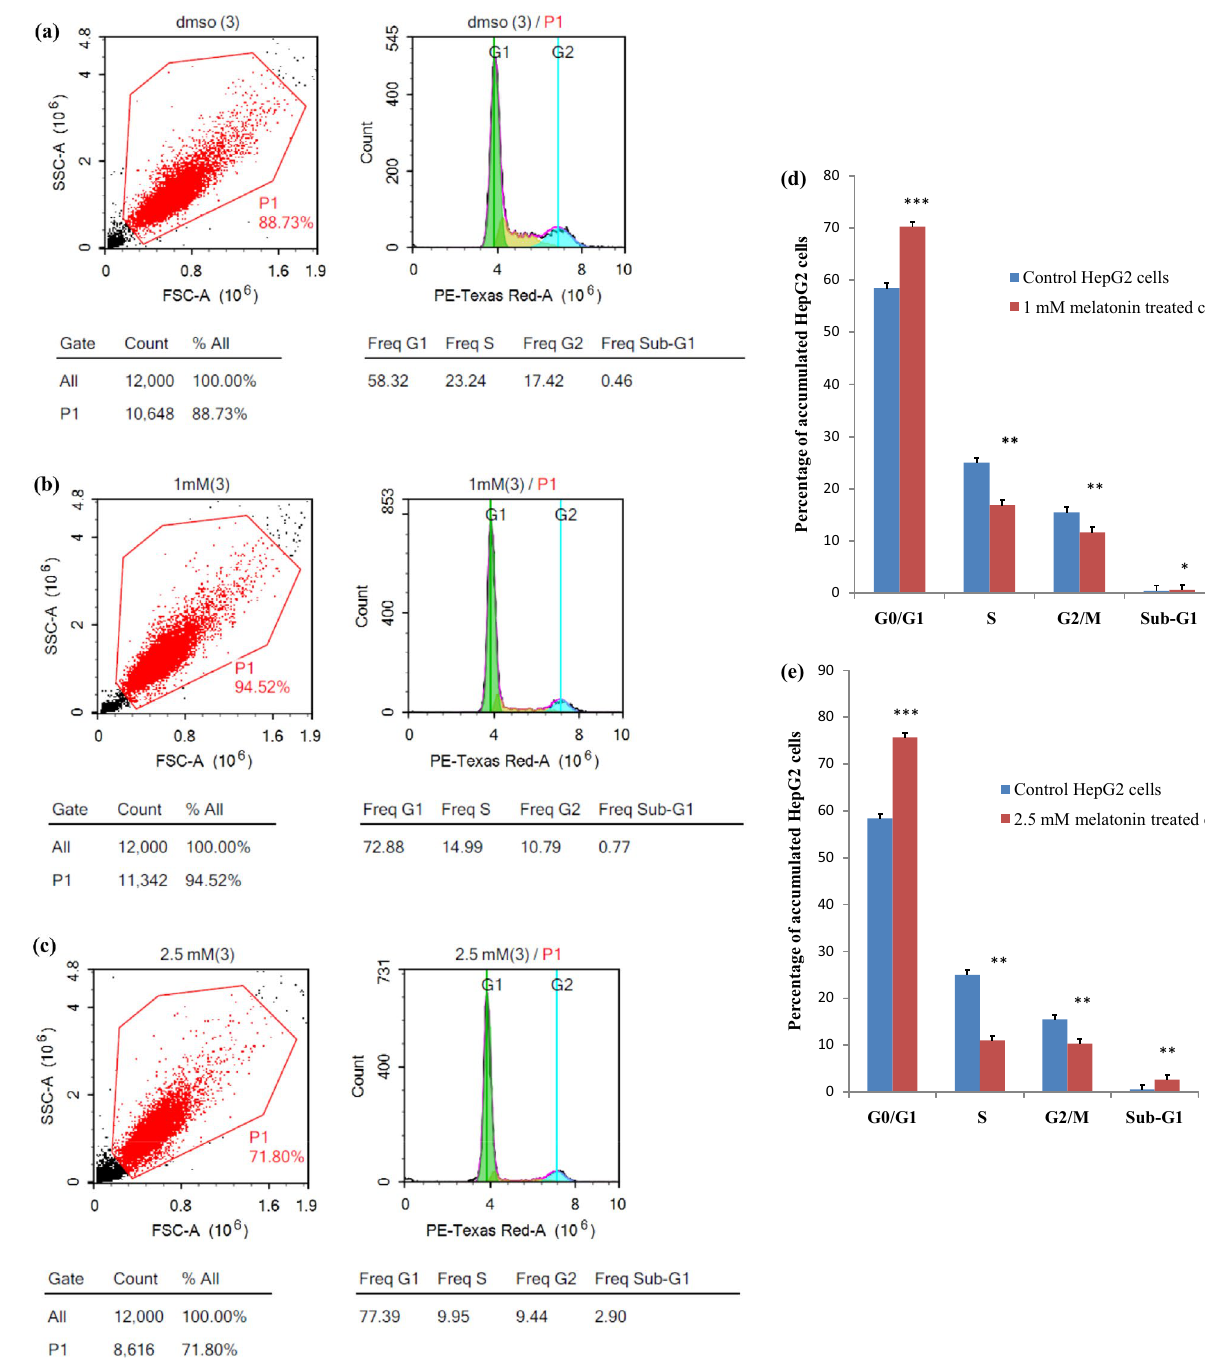
Figure 2. The cell cycles arrest induction by melatonin treatment. The effect of melatonin doses (1 mM, and 2.5 mM) for 24 h on HepG2 cell cycle distribution using flowcytometry is shown in representative charts ( a ) Cell cycle distribution in control vehicle untreated HepG2 cells, ( b ) cell cycle distribution in 1 mM melatonin treated HepG2 cells, ( c ) cell cycle distribution in 2.5 mM melatonin treated HepG2 cells, ( d ) the cell cycle distribution column chart of 1 mM melatonin-treated HepG2 cells, and ( e ) the cell cycle distribution column chart of 2.5 mM melatonin-treated HepG2 cells. Melatonin was detected to increase the accumulation of HepG2 cells in the G0/G1 phase of the cell cycle in percentages of 70.20% and 75.70% at melatonin concentrations of 1 mM and 2.5 mM, respectively. The experiment was repeated in triplicate. *** P < 0.001, ** P < 0.01, and * P < 0.05 as compared to